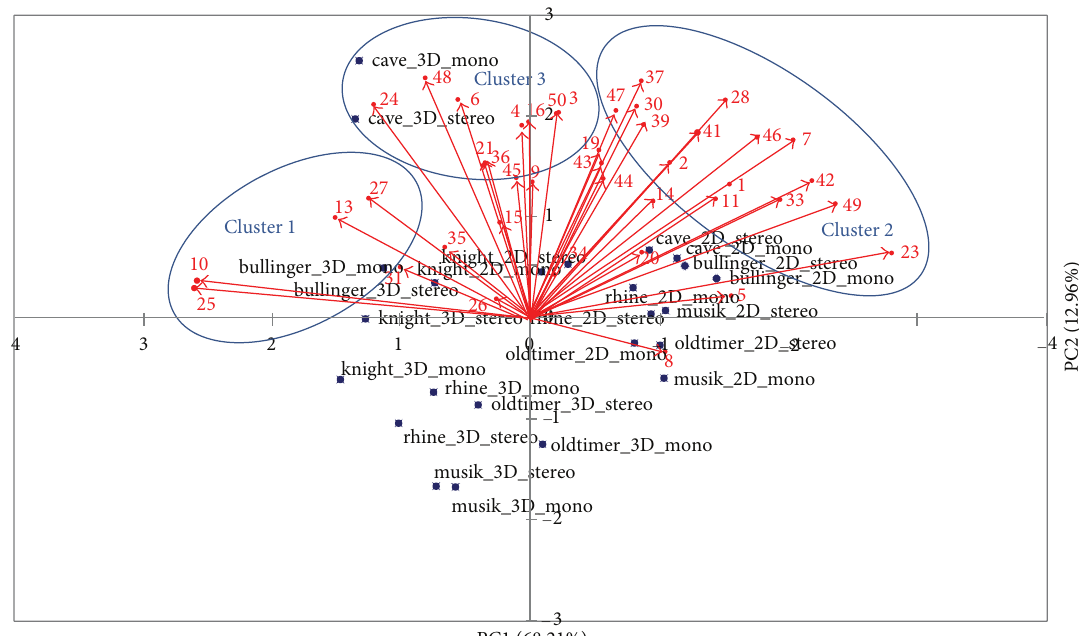
Figure 12: Objects and participants’ preferences in the preference map of PC1 and